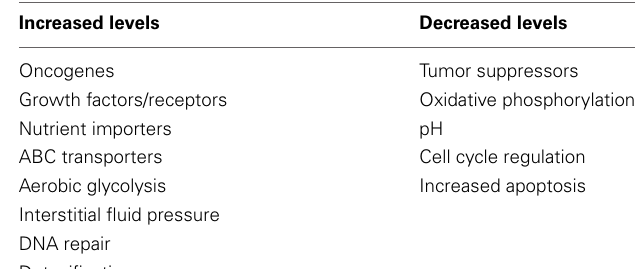
Table 2 | Tumor microenvironment characteristics contributing toward